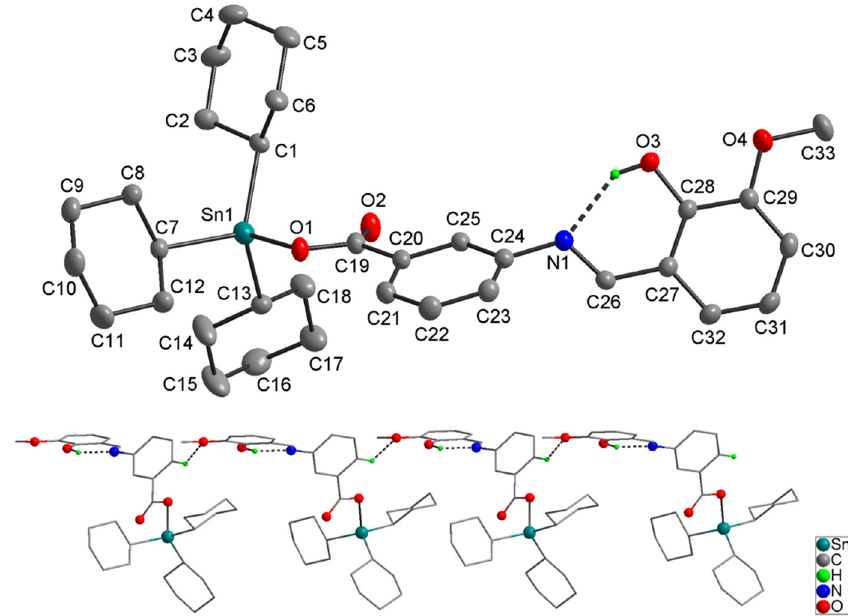
Figure 4: ( Top ) The molecular structure of 4. Ellipsoids are drawn at 30% probability level. Hydrogen atoms are omitted for clarity except H 3 atoms. ( Bottom ) One - dimensional supramolecular chain formed by the intermolecular C – H ⋯ O hydrogen bonds.